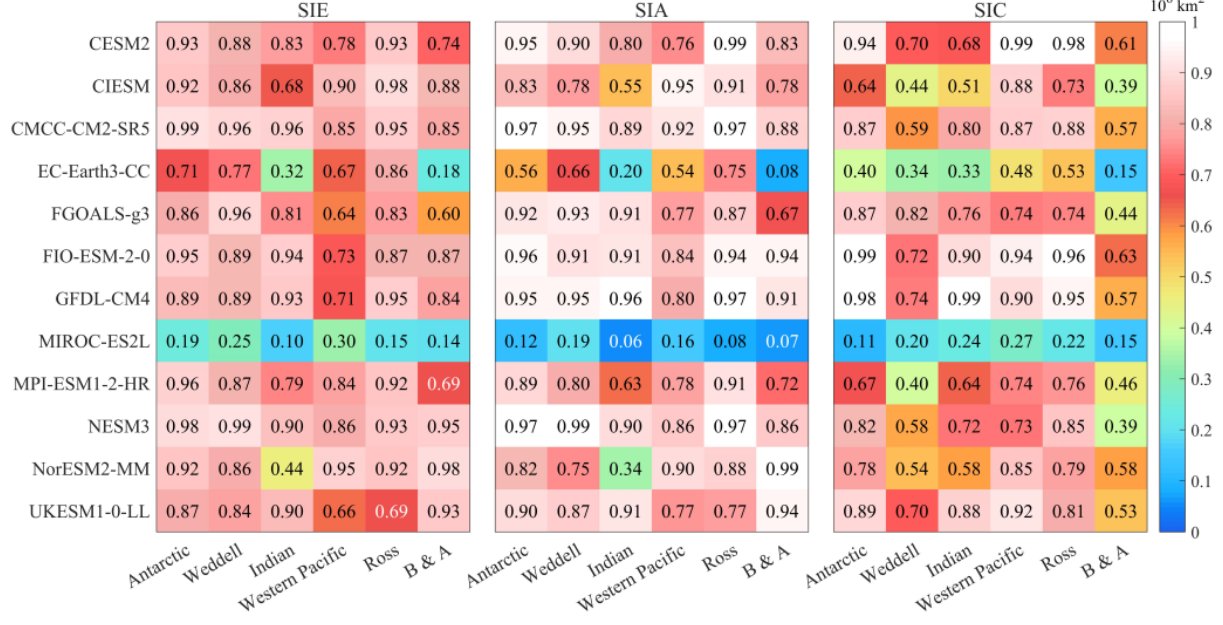
Figure 14. Taylor score of SIE, SIA, and SIC between the CMIP6 models and the observation in the whole Antarctic and five subregions over the period 2015–2021.